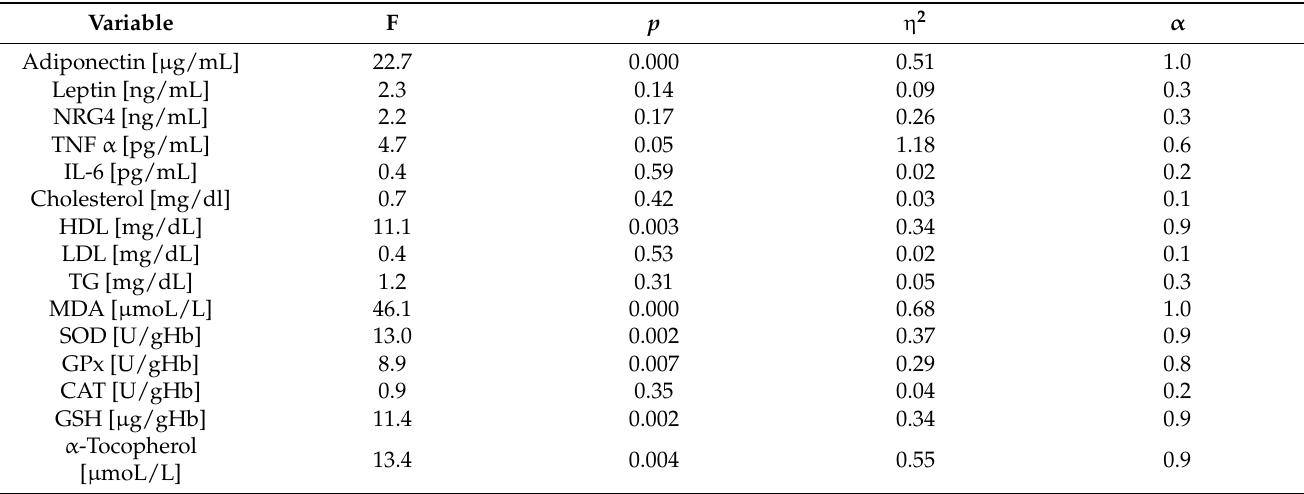
Table 5. Effect of ω -3 PUFA supplementation on adipocytokines, cytokines, lipid profile and antioxidant enzymes levels in supplemented group ( ω -3